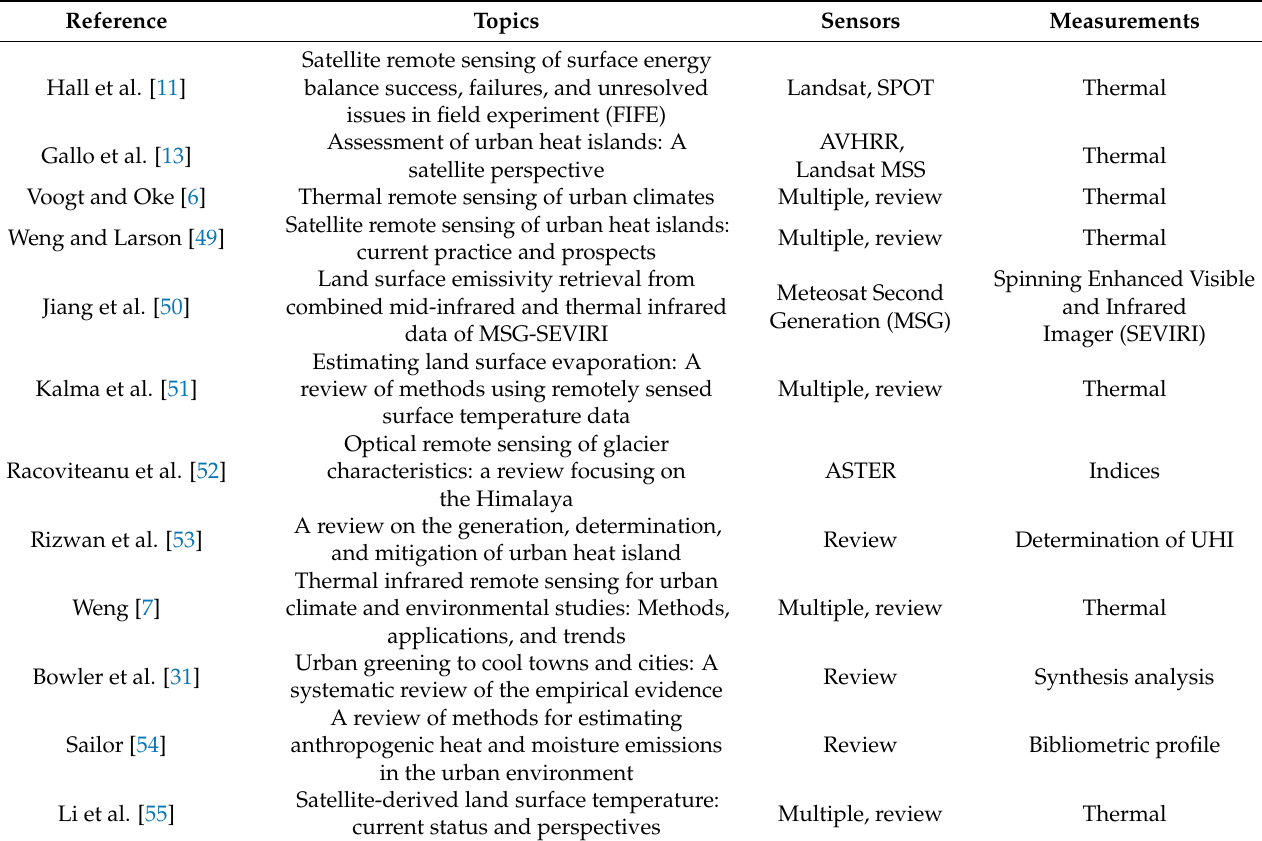
Table 1. Example of main reviews, bibliographies, and summaries on UHI and UHIRIP using remotely sensed data.